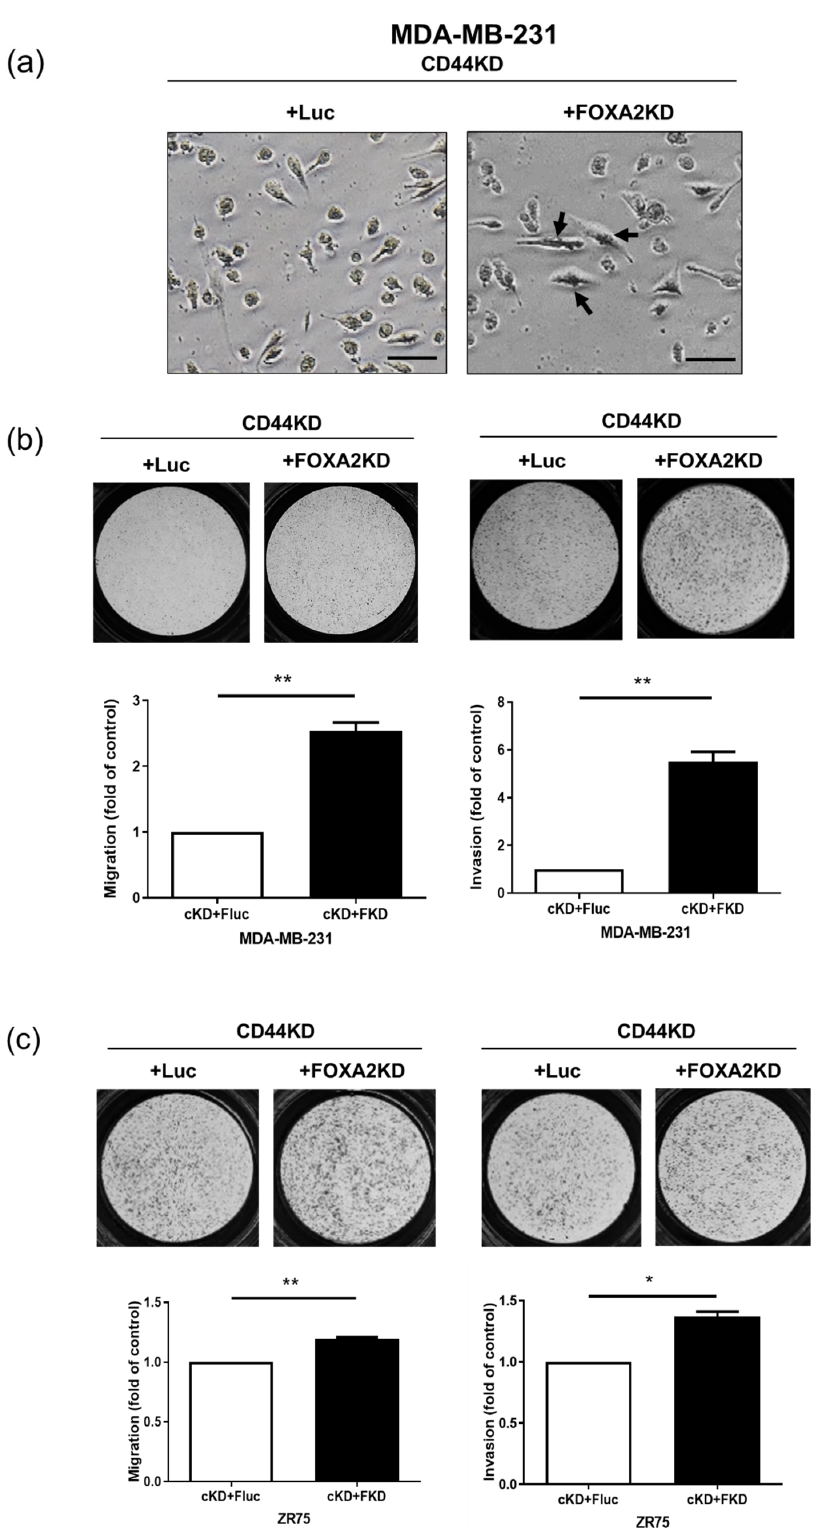
Figure 3. FOXA2 knockdown in CD44 knockdown cells reversed the epithelial phenotype to a mesenchymal phenotype: ( a ) Morphology of MDA-MB-231 cells with the double knockdown of CD44 and FOXA2. Scale bar = 50 µ m. ( b , c ) Migration and invasion abilities of MDA-MB-231 and ZR75 cells with the double knockdown of CD44 and FOXA2. The data are presented as the mean ± SD. * Indicates p < 0.05, and ** indicates p <